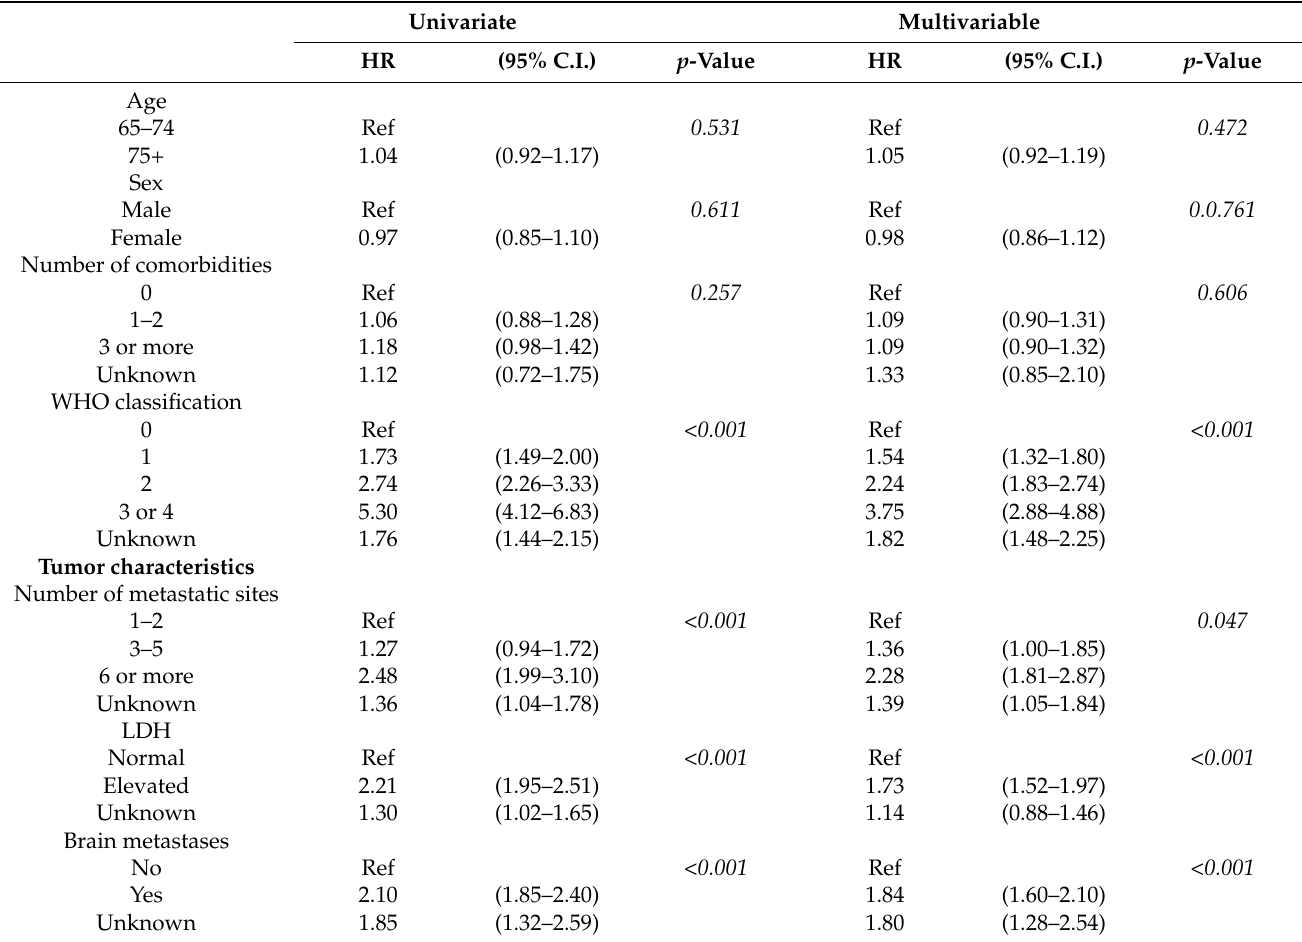
Table 4. Determinants of melanoma-specific